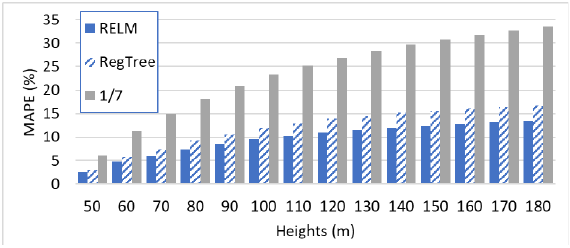
Figure 4. MAPE between different methods Despite having better MSE and MAPE values than the 1/7 Power Law (Table 2 and Figure 4), the RegTree Law, as shown in Figure 5. The proposed algorithm